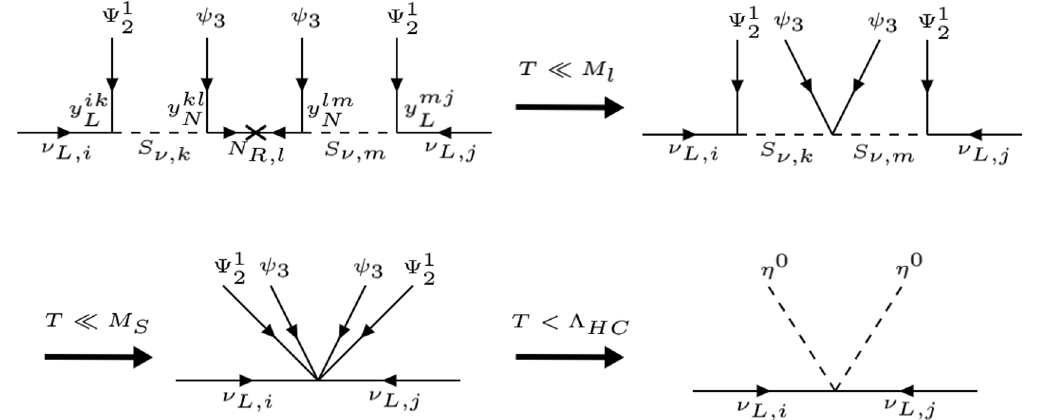
Figure 9 . Development of the ( η 0 ) 2 ( ν L ) 2 four-vertices for the FPC approach when M i (cid:29) M S from temperatures above M i down to zero-temperature by integrating out the propagators of the right-handed neutrinos, N R,l , with masses M l and the techni-scalars, S ν,k and S ν,m , with the mass M S . In this process, M i (cid:29) M S (cid:29) Λ HC